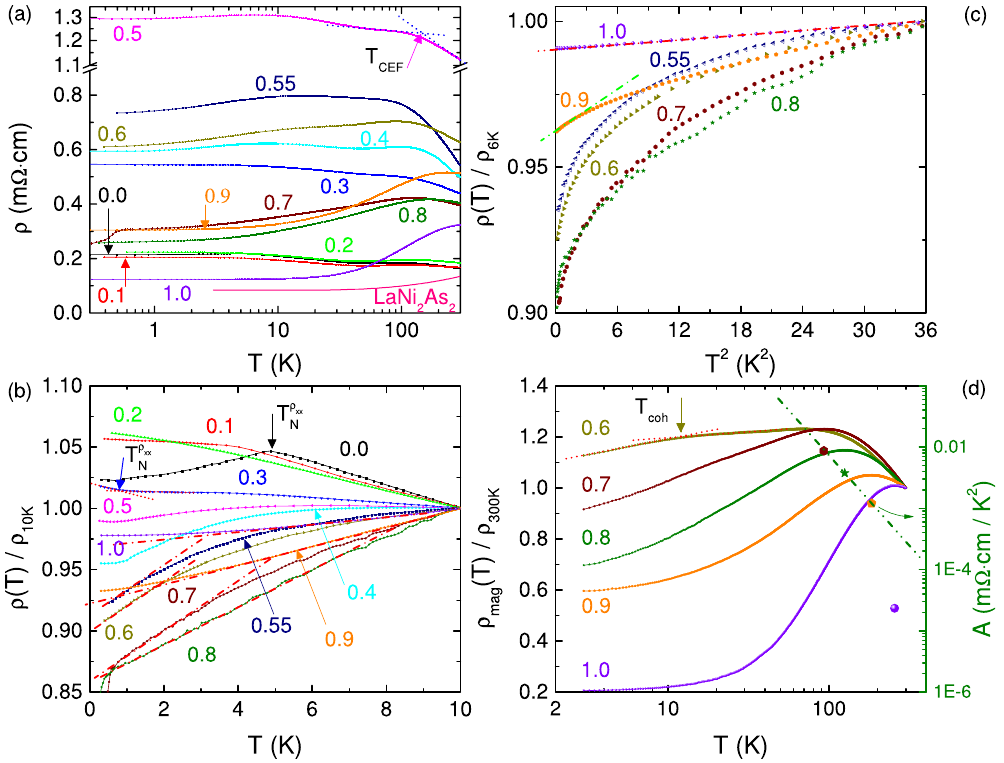
Figure 3. ( a ) Temperature dependence of the electrical resistivity ρ T ( ) for CeNi 2 − δ (As 1 − x P x ) 2 series as well as xx LaNi 2 As 2 in a log-log scale. The normalized resistivity for the selected concentrations is shown as ρ / ρ 10 K versus xx ρ / ρ versus T 2 below 6 K in ( c ), respectively. The dashed-dotted lines are linear fit to T below 10 K in ( b ) and xx K 6 ρ . The normalized resistivity T ( ) ρ / ρ at T = 2–400 K on the left axis of ( d ) for x = 0.6–1.0 samples. The log- xx xx K 300 2 ∝ . log plot of A coefficient versus T coh on the right axis of ( d ). The dashed-dotted-dotted line indicates A T ( ) coh T CEF ( T coh ) is shown by an arrow for x = 0.5 sample in ( a ) ( x = 0.6 in ( d )).